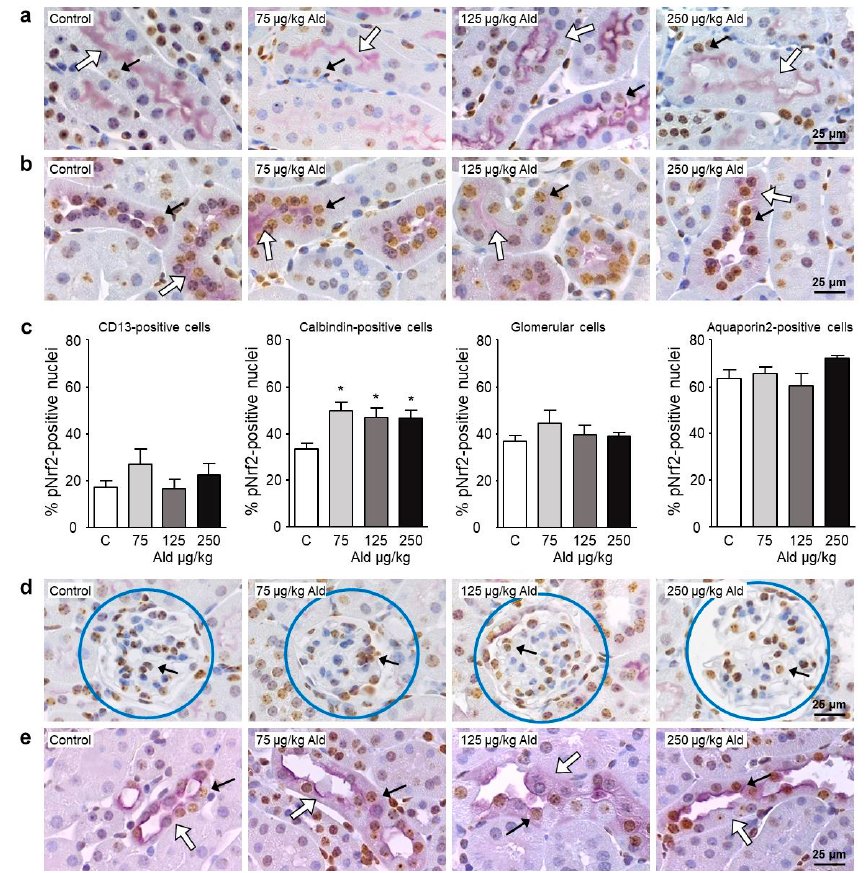
Figure 7. Localization of the activated transcription factor Nrf2. ( a , b , d , e ) Representative images of those used for the localization of pNrf2 in kidney cells. Double staining on paraffin-embedded kidney sections was carried out using antibodies against pNrf2 (brown staining) and against cell-specific antigens (purple staining; ( a ) CD13, a marker specific for proximal tubule cells, located in the brush border; ( b ) calbindin, a marker specific for distal tubule cells and upper collecting duct cells, located in the cytosol; ( d ) glomeruli were identified due to their unique structure highlighted by the blue circles; ( e ) aquaporin 2, a marker for collecting duct cells and late distal tubular cells). Examples of pNrf2-positive stained nuclei are marked with black arrows, the staining specific for the kidney cell type is indicated with a white arrow. ( c ) Quantification of pNrf2-positive nuclei in the four kidney structures related to the number of nuclei in purple stained structures in 10 visual fields. For the quantification in the glomerulus, 50 glomeruli were evaluated. Ald: aldosterone, Nrf2: nuclear factor-erythoid-2-related factor 2. Data are shown as mean + SEM, n = 5. * p ≤ 0.05 vs. C: control group.